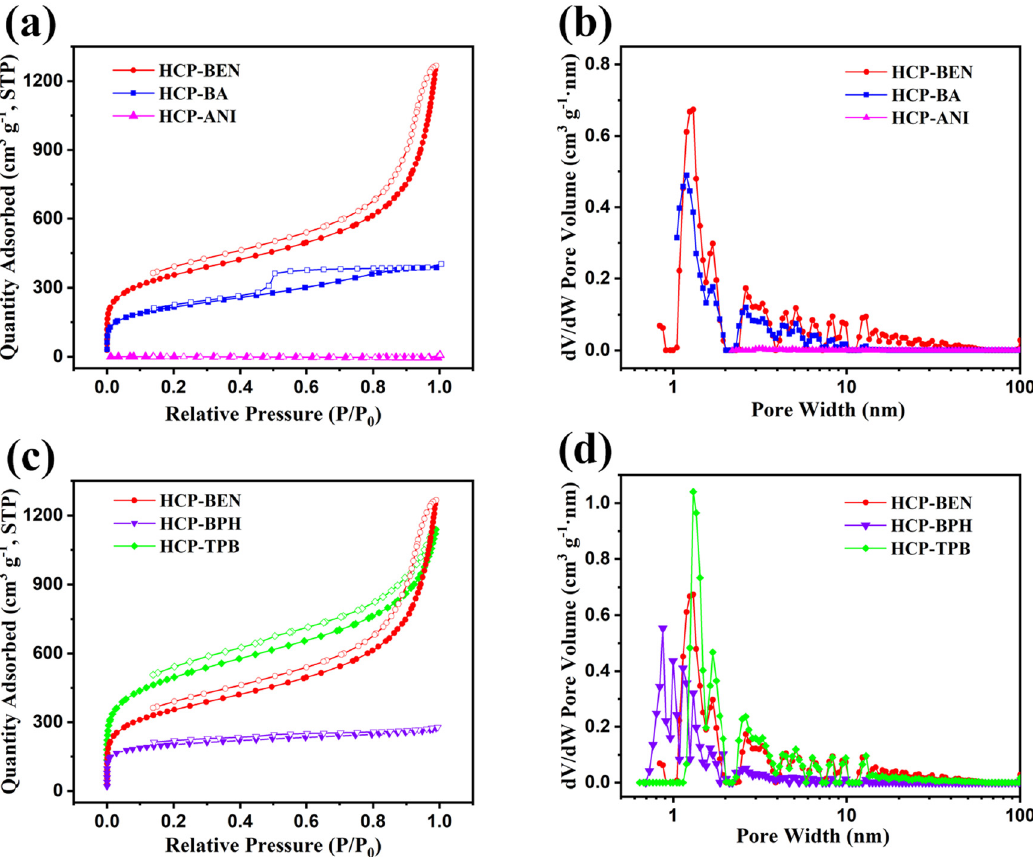
Figure 5: ( a and c ) Nitrogen adsorption/desorption isotherms and ( b and d ) pore size distributions of HCPs prepared from veri fi ed